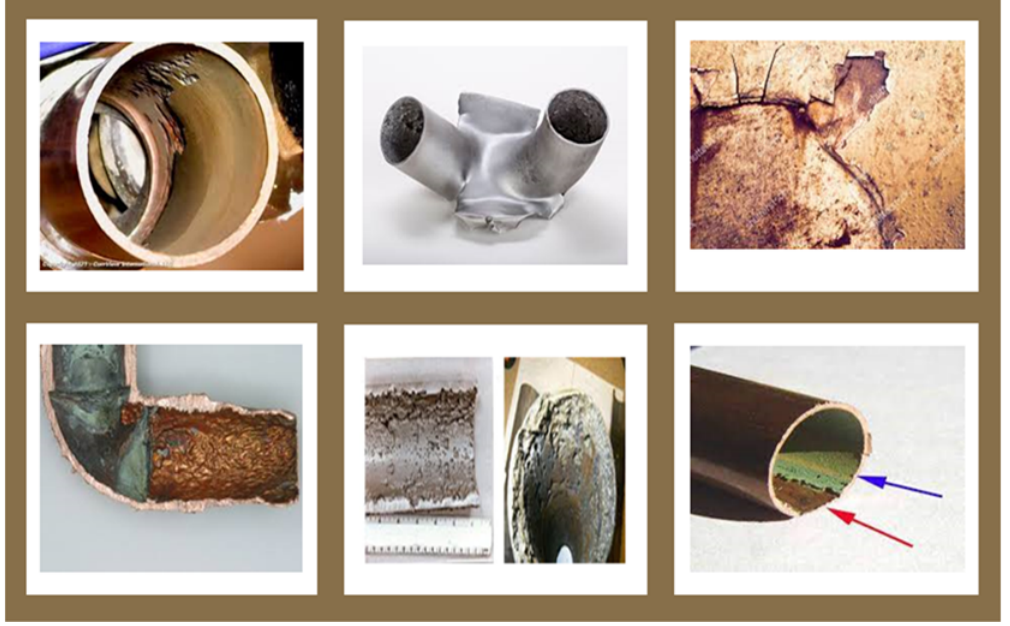
Figure 1. Erosion effects on surfaces.